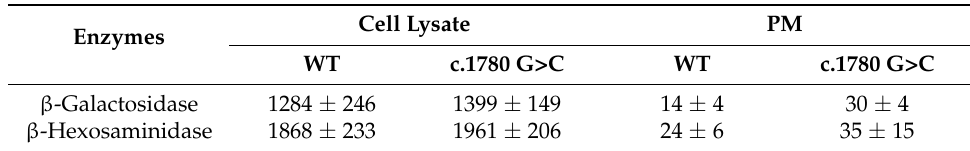
Table 3. Enzymatic activities associated with total cell lysate and the plasma membrane (PM) of control (WT) and patient (c.1780 G>C) derived LCLs. Enzymatic activities were expressed as pmoles/10 6 cells/h ±